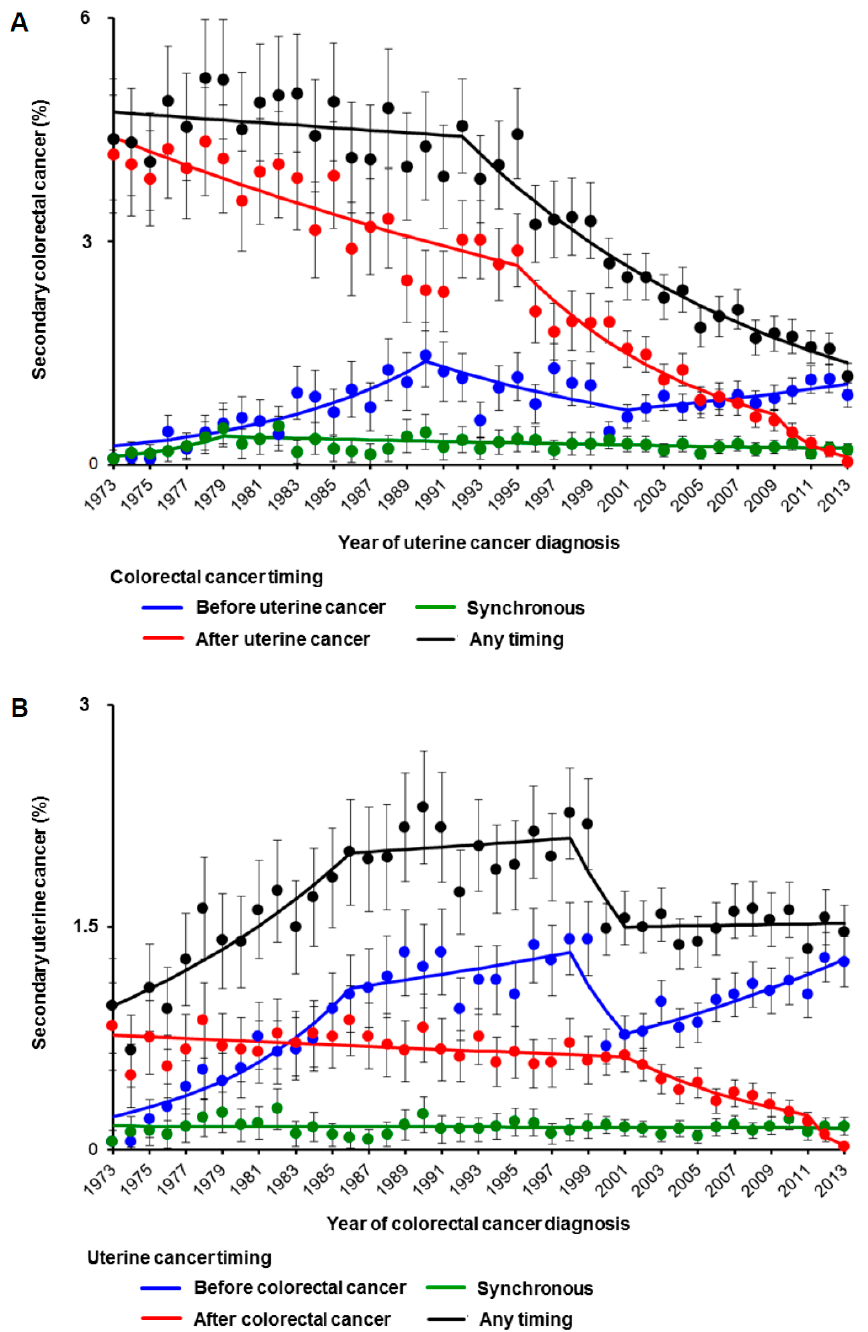
Figure 2. Trends in secondary primary cancer per year. Temporal trends are shown for ( A ) secondary colorectal cancer among uterine cancer and ( B ) secondary uterine cancer among colorectal cancer based on the timing of secondary primary cancer. Dots represent actual observed values. Bars represent standard confidence intervals. Colored lines represent modeled lines. Raw results of temporal trends are shown in Supplemental Table S4.